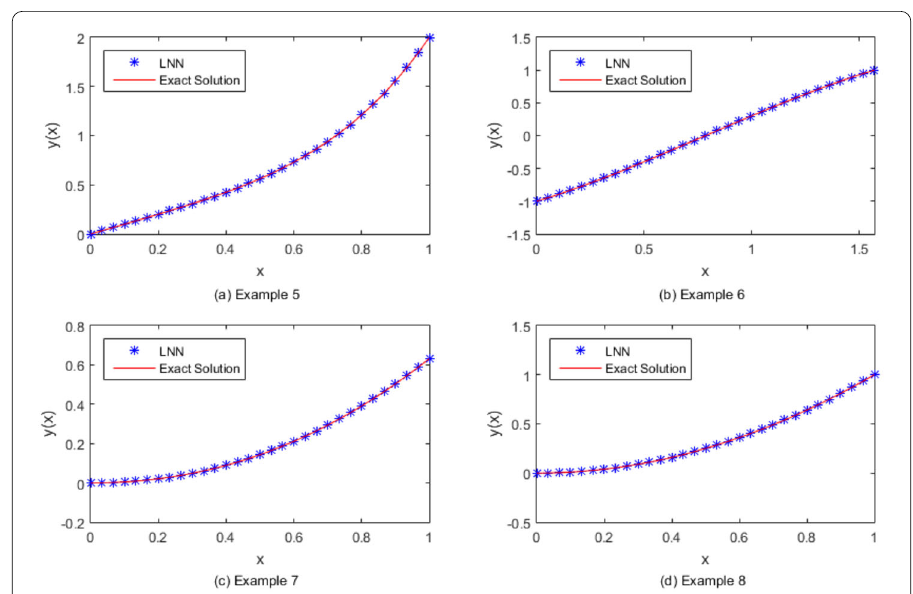
Figure 4 Comparison between exact and LNN results for second-order